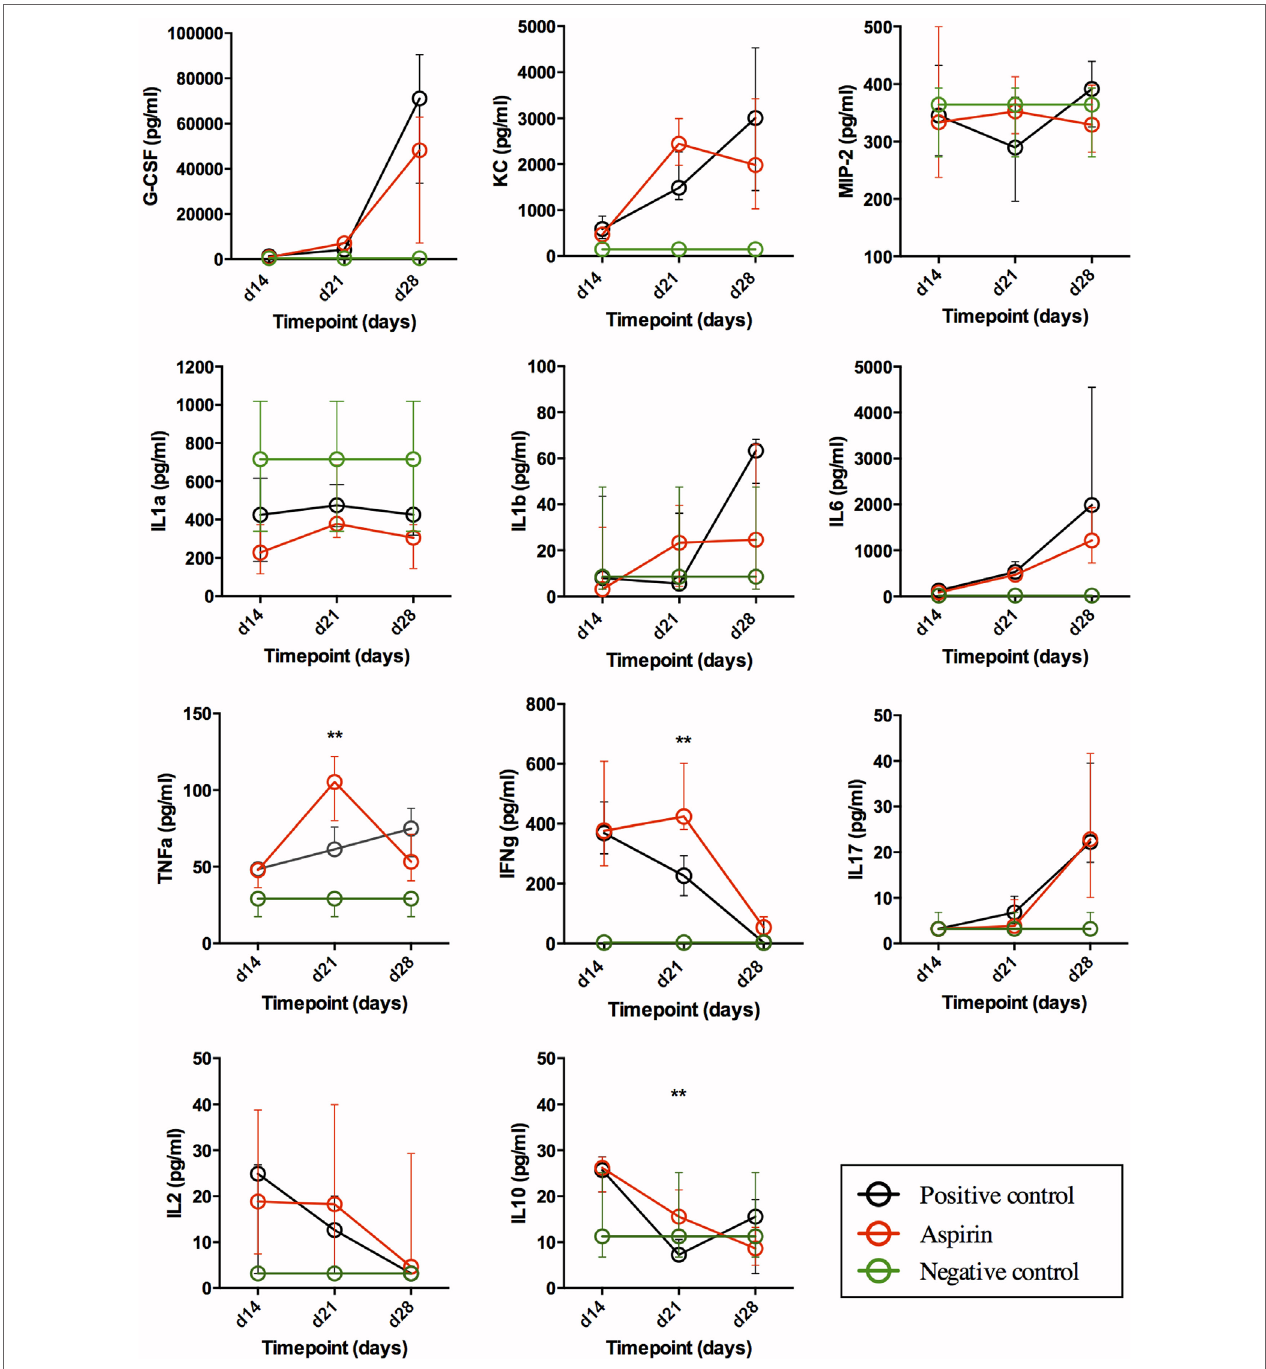
FigUre 3 | Impact of AAS on serum cytokine/chemokine levels. All data are presented in pg/mL. Abbreviations: AAS, aspirin; G-CSF, granulocyte-colony stimulating factor; KC, chemokine (C-X-C motif) ligand 1 (CXCL-1); MIP-2, macrophage inflammatory protein 2-alpha [also named chemokine (C-X-C motif) ligand 2 (CXCL2)]; IL, interleukin; TNFa, tumor necrosis α ; IFNg, interferon γ